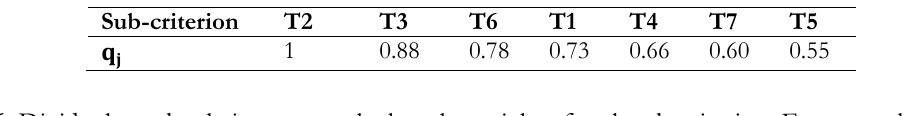
Table 10. Values of 𝒒 𝒋 for each